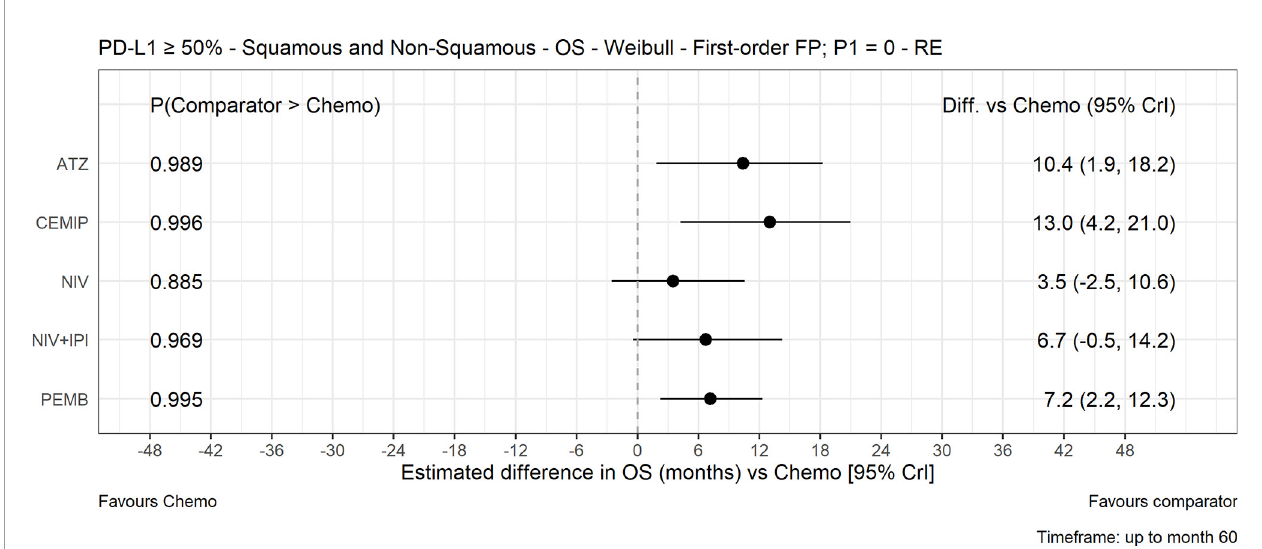
FIGURE 2 | Expected OS difference with chemotherapy versus cancer immunotherapy comparators, mixed histology (60-month time horizon). Median posterior estimate and 95% posterior CrI. ATZ, atezolizumab; CEMIP, cemiplimab; chemo, chemotherapy; Diff., difference; NIV, nivolumab; NIV+IPI, nivolumab plus ipilimumab; OS, overall survival; PD-L1, programmed death-ligand 1; PEMB, pembrolizumab; FP, fractional polynomial; P1=0, Weibull; RE, random